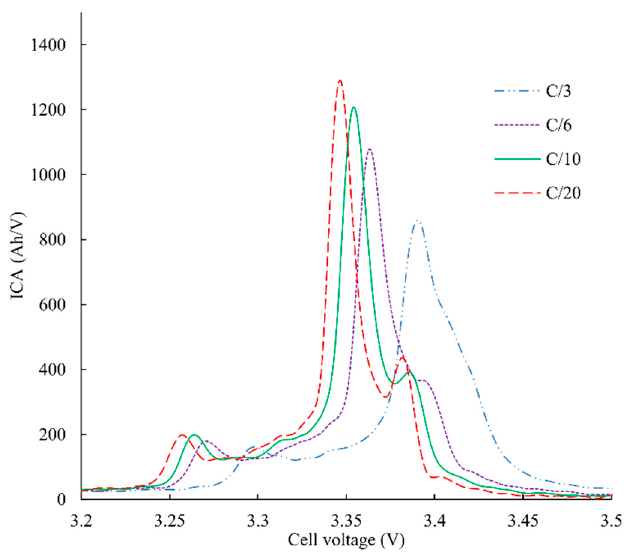
Figure 9. ICA deformation function of the charging current (100% DoD-25 °C-SoH 80%).